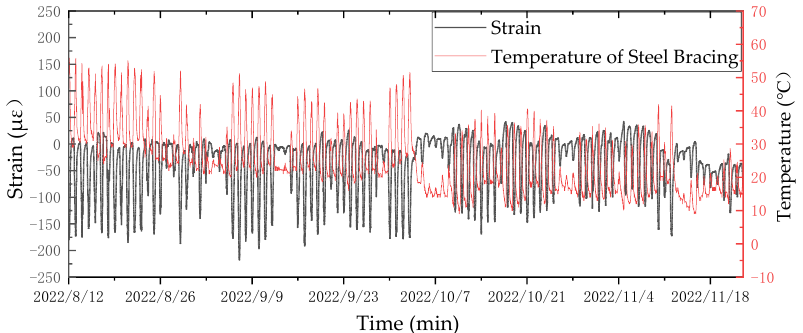
Figure 9. Temperature–strain diagram of steel assembly bracing during monitoring period (12 August to 22 November 2022).